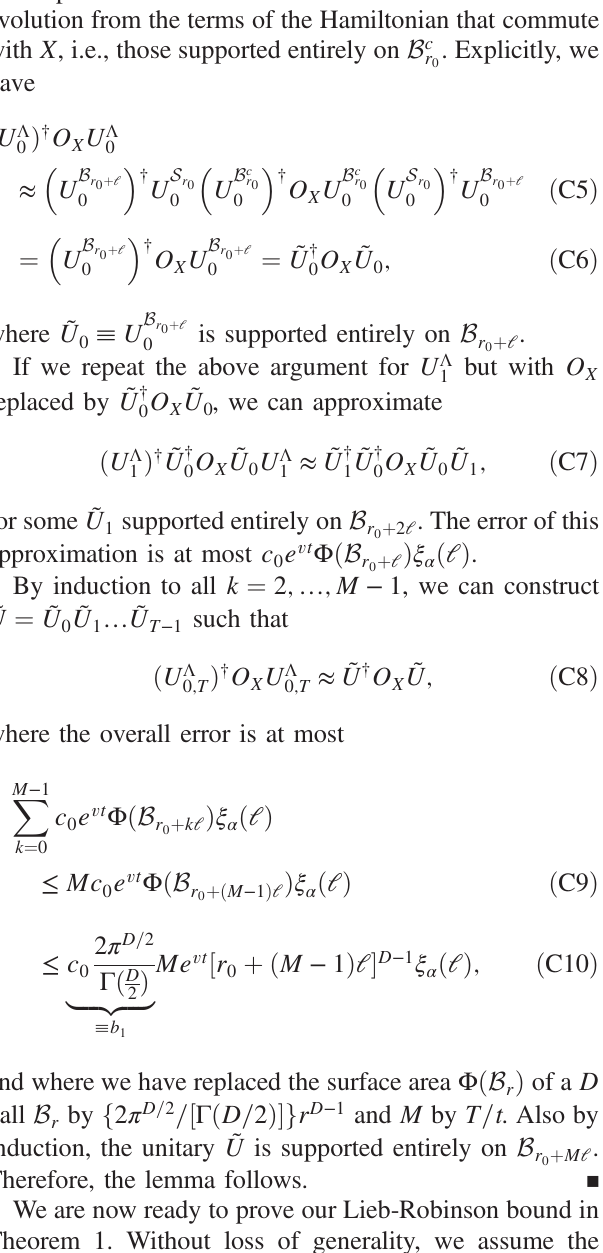
, the complement of the ball B r 0 þ 5 l